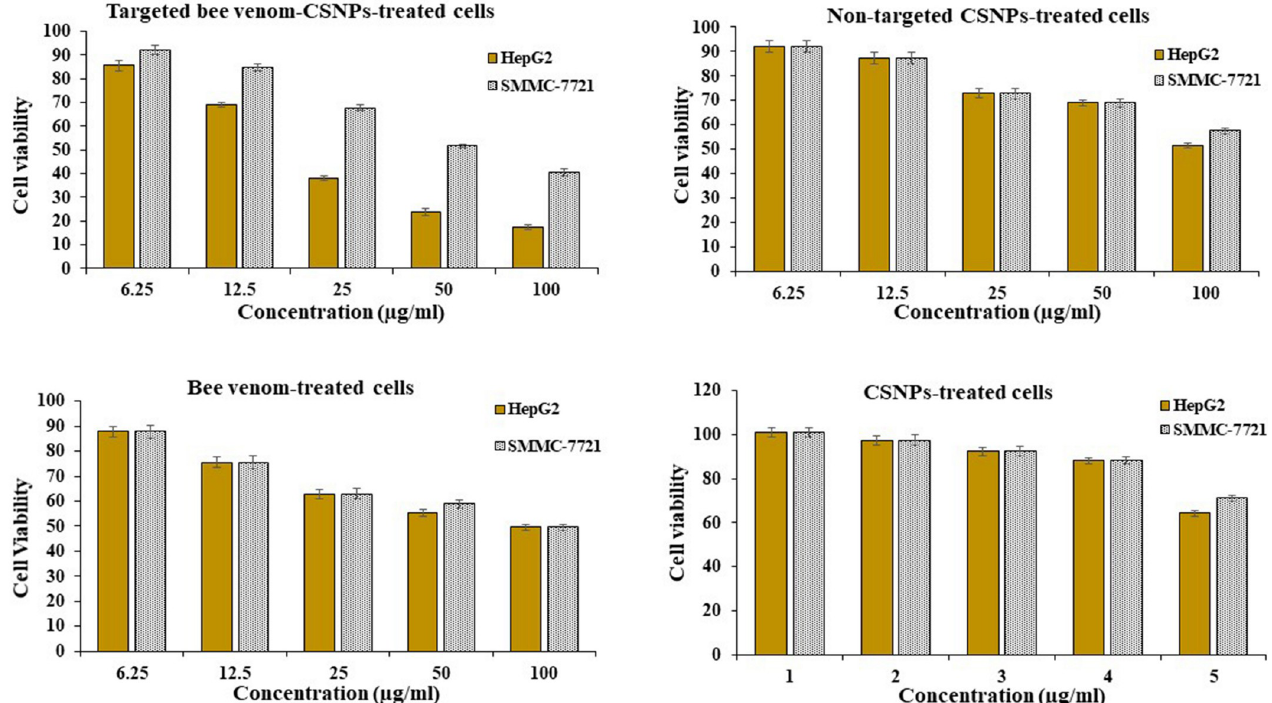
Fig 4. Cell viability of HepG2 and SMMC-7721. Relationship between targeted bee venom-CSNPs, non-targeted CSNPs, native bee venom, and CSNPs concentrations and viability percentage on HepG2 and SMMC-7721 cells.